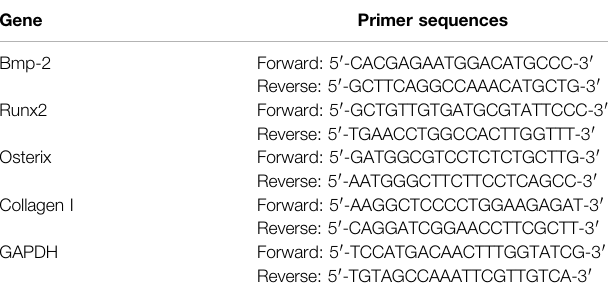
TABLE 1 | RT-qPCR primer sequences. Gene Primer